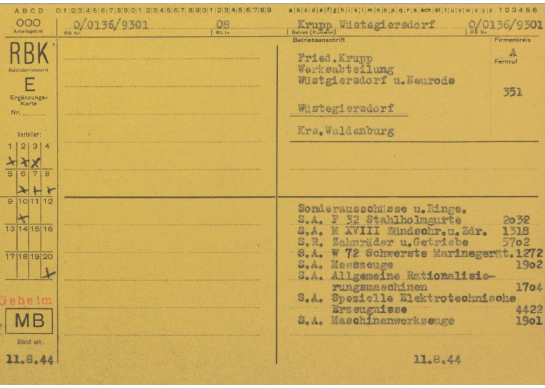
Figure 2. Production chart for the Krupp facility in Wustgiersdorf (Głuszyca) that includes a list of the produced elements. Source: Bundesarchiv R3/2006.